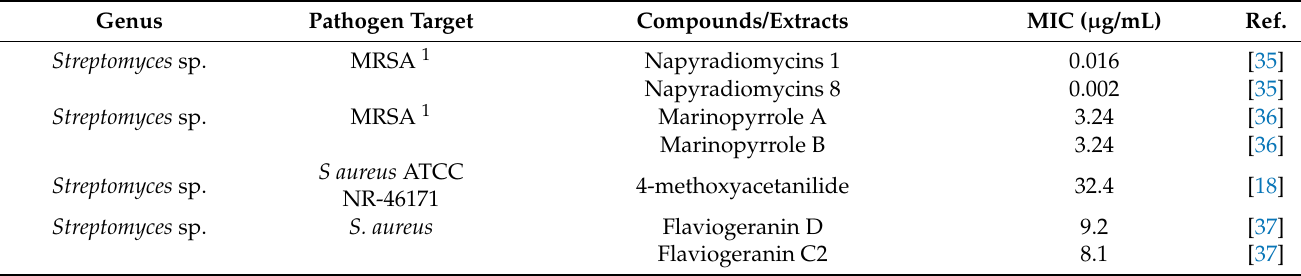
Table 1. Antibacterial capacity of actinobacterial crude extracts or